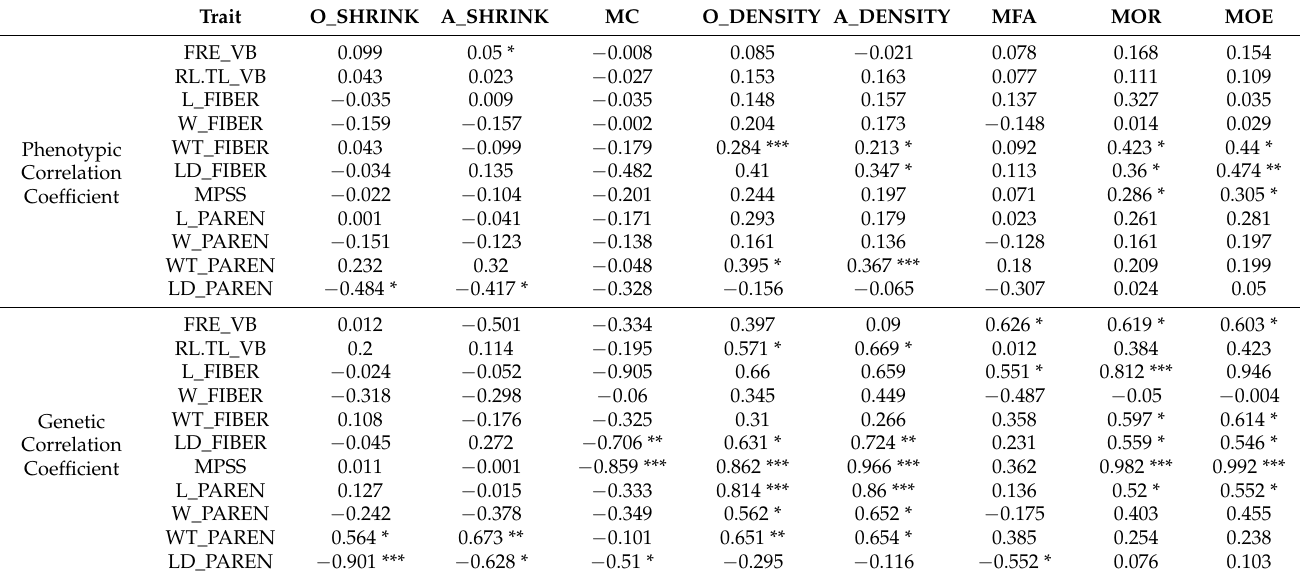
Table 4. Correlation analysis between cell structure and material properties in Moso bamboo ( Phyllostachys edulis